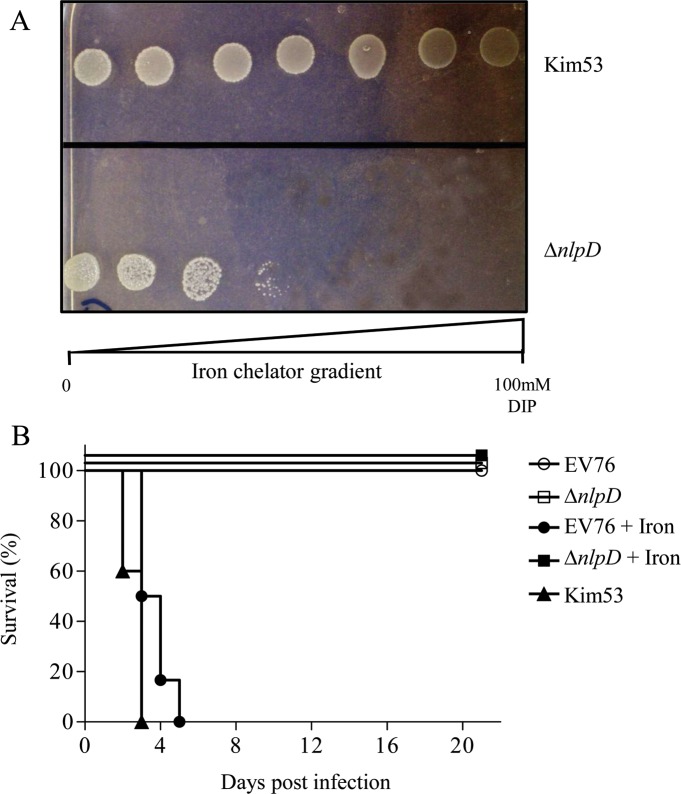
Role of iron in nlpD mutant growth and pathogenesis.A. Growth of Y. pestis strains under iron-limiting conditions. Kim53 (upper panel), Kim53ΔnlpD (lower panel). The displayed data is one representative experiment. B. Survival curves of iron-treated mice infected with attenuated Y. pestis strains. Two groups of 12 mice were infected with the attenuated Y. pestis EV76 (circles) or Kim53ΔnlpD (square) strains (s.c. infection with 107 cfu/mouse). In each group, six mice were treated with iron dextran (filled symbols), and six mice served as control (open symbols). Survival curve of mice infected with the Y. pestis Kim53 strain (s.c. infection with 106 cfu/mouse, triangles).